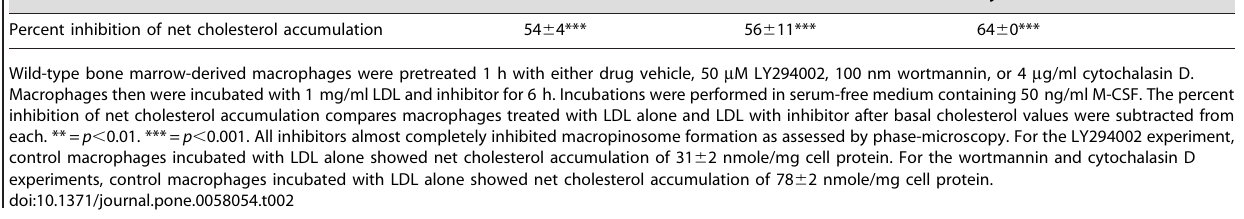
Table 2. The effect of PI3K inhibitors and cytochalasin D on net cholesterol accumulation in wild-type macrophages.